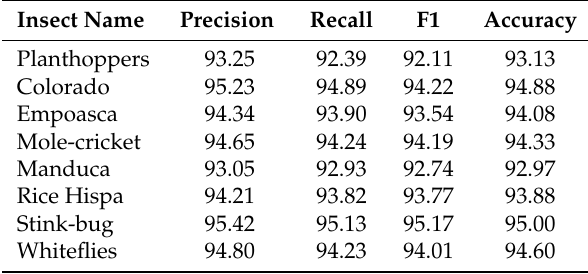
Table 3. Statistical measures for farm field insects